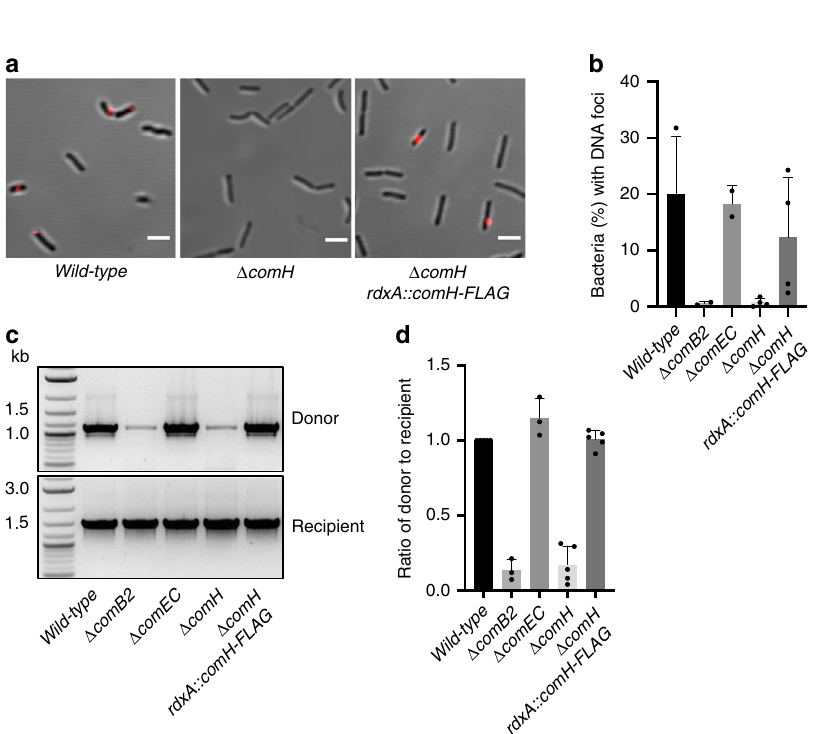
Fig. 1 ComH is essential for tDNA import into the periplasm. a Fluorescent DNA foci formation in H. pylori wild-type, Δ comH and Δ comH redxA::comH-FLAG strains. Z maximum projections of merged images of ATTO-550 (red channel) and differential interference contrast (DIC) are presented. Scale bar = 2.5 µ m. b Percentage of bacteria with fl uorescent DNA foci from the experiments described in a . The mean and standard deviation values calculated from at least two independent experiments are shown for wild-type ( n = 661), Δ comB2 ( n = 633), Δ comEC ( n = 1068), Δ comH ( n = 989) and Δ comH rdxA:: comH-FLAG ( n = 5245) cells. Bars correspond to the mean + /- SD. c The presence of donor DNA in the periplasm was monitored by PCR. The products of ampli fi cation were visualised by agarose gel electrophoresis. d The ratios of donor versus recipient ampli fi cation were obtained by scanning of the agarose gels using ImageJ and the results were normalised with respect to the wild-type strain. Bars correspond to the mean of at least 3 independent experiments + /-